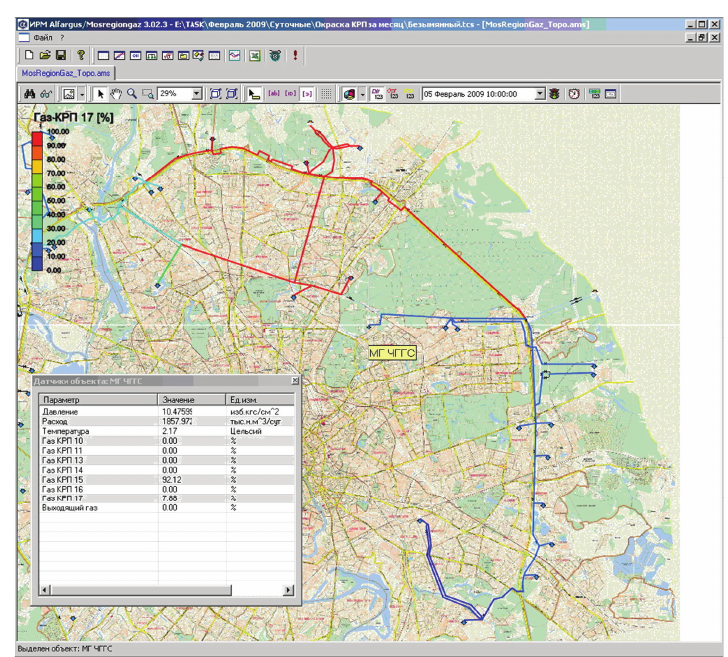
Figure 5: Numerical simulation of natural gas supply from GDS-17 to Moscow Ring Gas Distribution Pipeline System (cid:5) an example of instant of time (cid:6) .